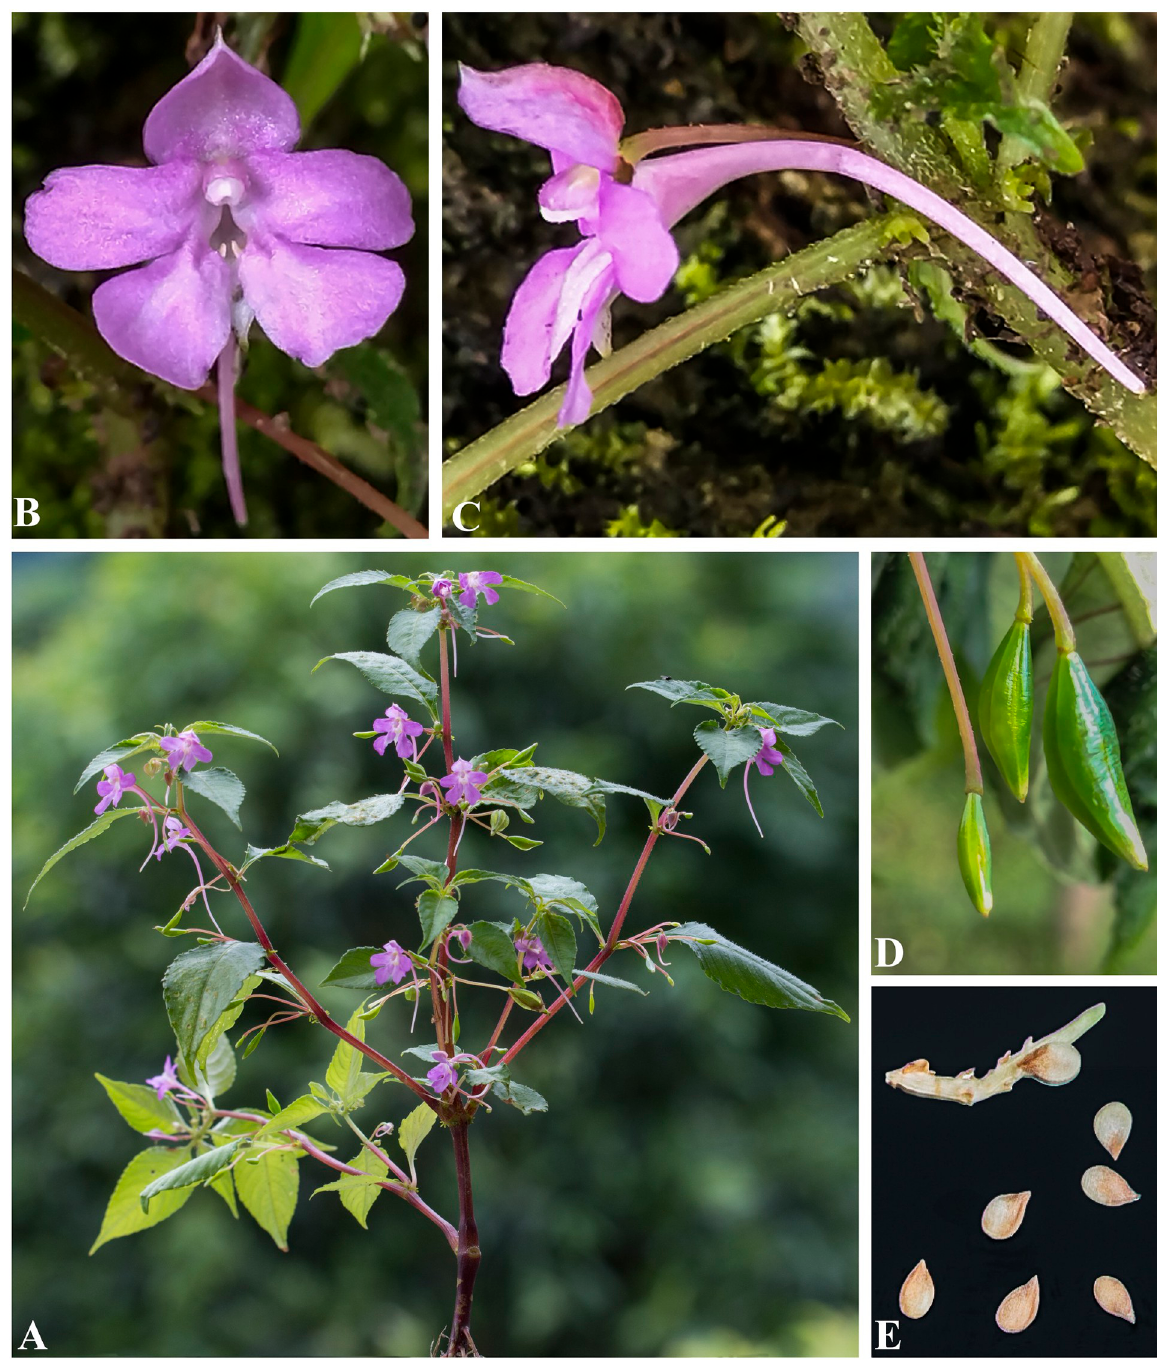
Fig 11. Impatiens exilis A. Flowering plant; B. Front view of flower; C. Flower (side view); D, Capsule; E, Seed. Photographs by Bhakta Bahadur Raskoti.